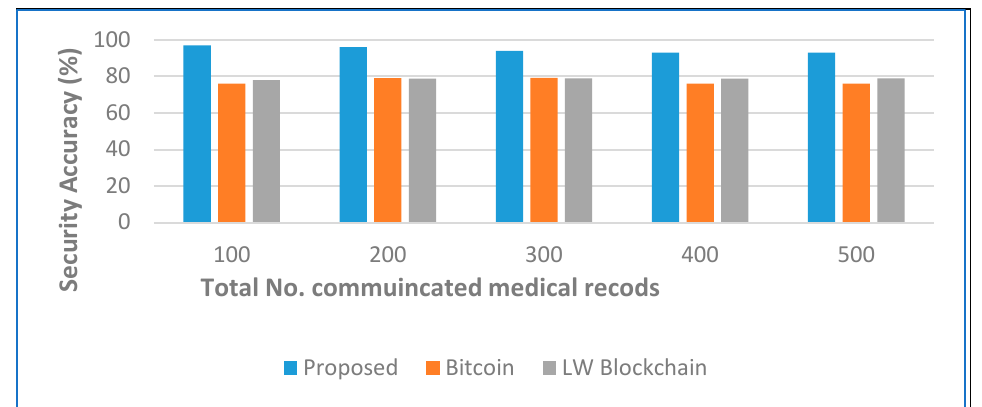
Figure 7. Total processing time and restoring time of blocks against the increase in the number of nodes.